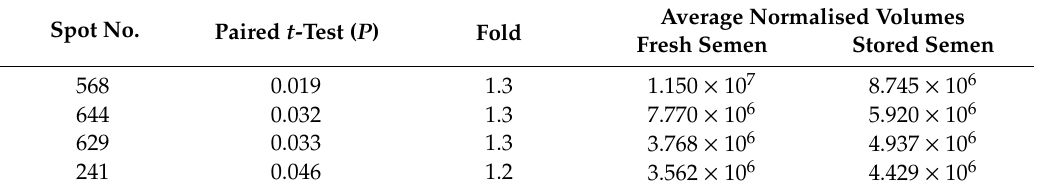
Table 2. Di ff erences in expression of 4 spots between fresh and liquid stored sperm. Table 2. Differences in expression of 4 spots between fresh and liquid stored sperm. Average Normalised Volumes Spot No. Paired t -Test ( P ) Fold Spot No. Paired t -test ( P ) Fold Fresh Semen Stored